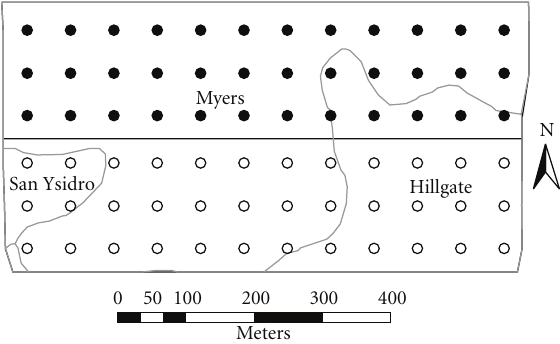
Figure 2: Layout of sampling points. The sampling points on the 64m grid are indicated with solid circles for the north and open circles for the south